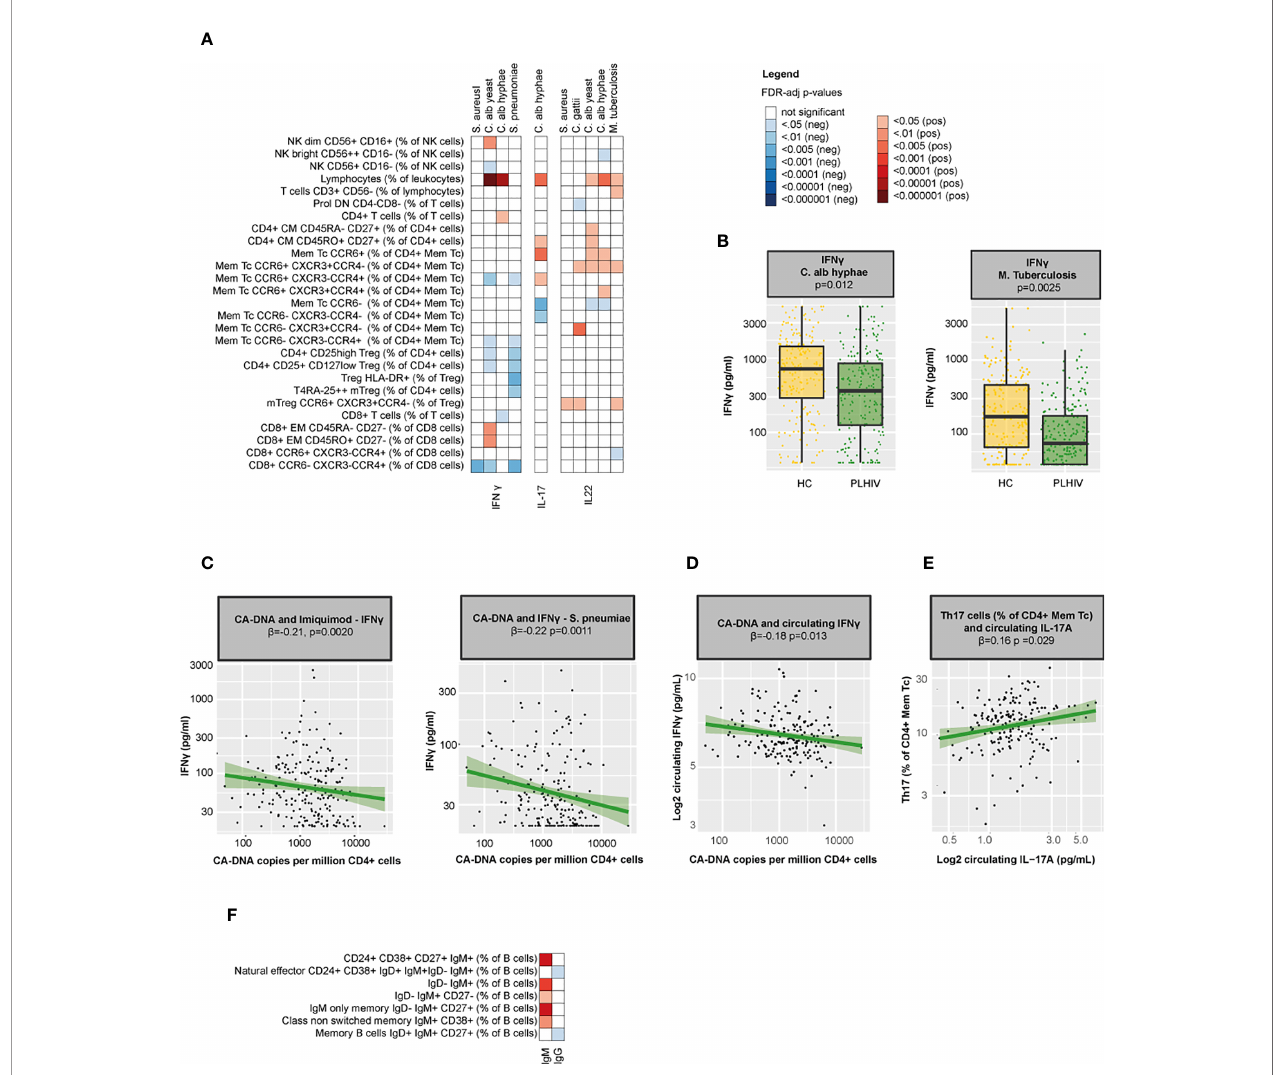
FIGURE 6 | Functional consequences of WBC alterations in PLHIV (A) Heatmap of NK(T) and T cell percentages (total n=71) that were signi fi cantly associated with the ex vivo production of IFN- g , IL-17, and IL-22 upon seven days ex vivo stimulation of PBMCs with different stimuli (n=7) in 211 PLHIV; WBC subsets that showed no signi fi cant correlations with any of the parameters (n=44) have been removed from the fi gure. (B) Boxplot showing differences in ex vivo IFN- g responses upon stimulation with C. albicans and M. tuberculosis between PLHIV (n=211) and healthy controls (n=56). (C) Association between CA-DNA and ex vivo IFN- g responses to stimulation with Imiquimod and S. pneumoniae in PLHIV. (D) Association between CA-DNA and circulating IFN- g in PLHIV. (E) Association between Th17 percentages and circulating IL-17A in PLHIV. (F) Heatmap of B cell percentages (total n=28) that were signi fi cantly correlated with IgM or IgG levels in PLHIV; WBC subsets that showed no signi fi cant correlations with any of the parameters (n=21) have been removed from the fi gure. Inverse-rank transformed data were analyzed using linear regression analyses and corrected for sampling time. For cohort comparisons, data were corrected for age, sex, sampling time, season and the CD4+ and CD8+ cell percentages. For color coding of the FDR-adjusted p-values see legend. CA-DNA, CD4-cell-associated HIV-1 DNA; HC, healthy control; IFN- g , interferon gamma; Ig, immunoglobulin; IL-17(A), interleukin 17(A); IL-22, interleukin 22; Mem Tc, CD4+ memory T cell; NK(T) cells, natural killer (T) cells; PBMC, peripheral blood mononuclear cell; PLHIV, people living with HIV; sCD14, soluble CD14; Th17 percentages, T-helper 17 cell percentages (Mem Tc CCR6+ CXCR3- CCR4+ as percentage of CD4+ Mem Tc); WBC, white blood